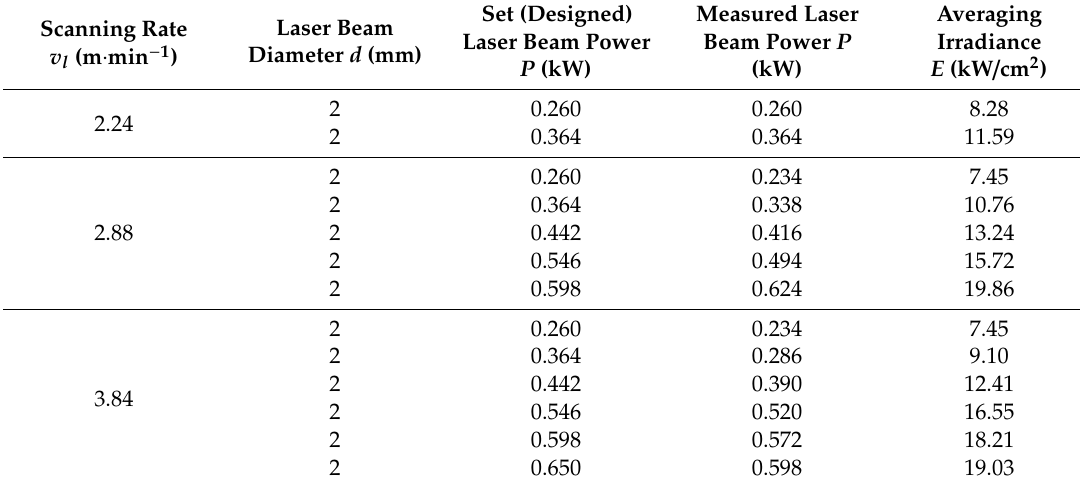
Table 1. Parameters of the laser heat